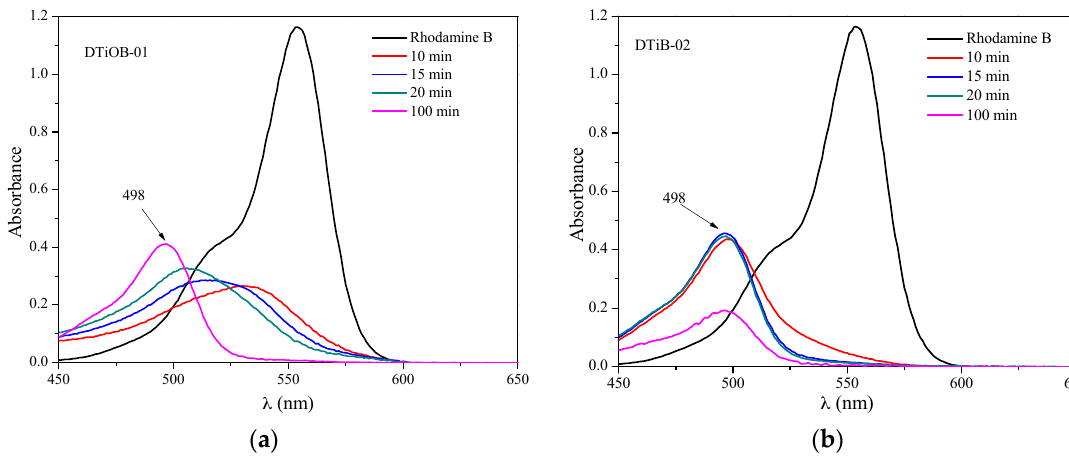
Figure 9. Hypsochromic shift detected during the degradation process of Rhodamine B with ( a ) DTiB-01 and ( b ) DTiB-02.